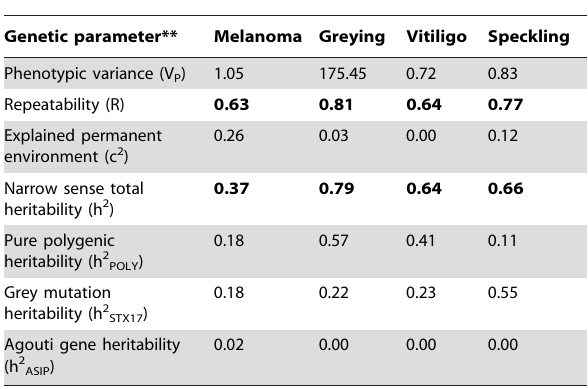
Table 2. Phenotypic variance, repeatability, and heritabilities for melanoma grade, grey level, vitiligo grade, and speckling